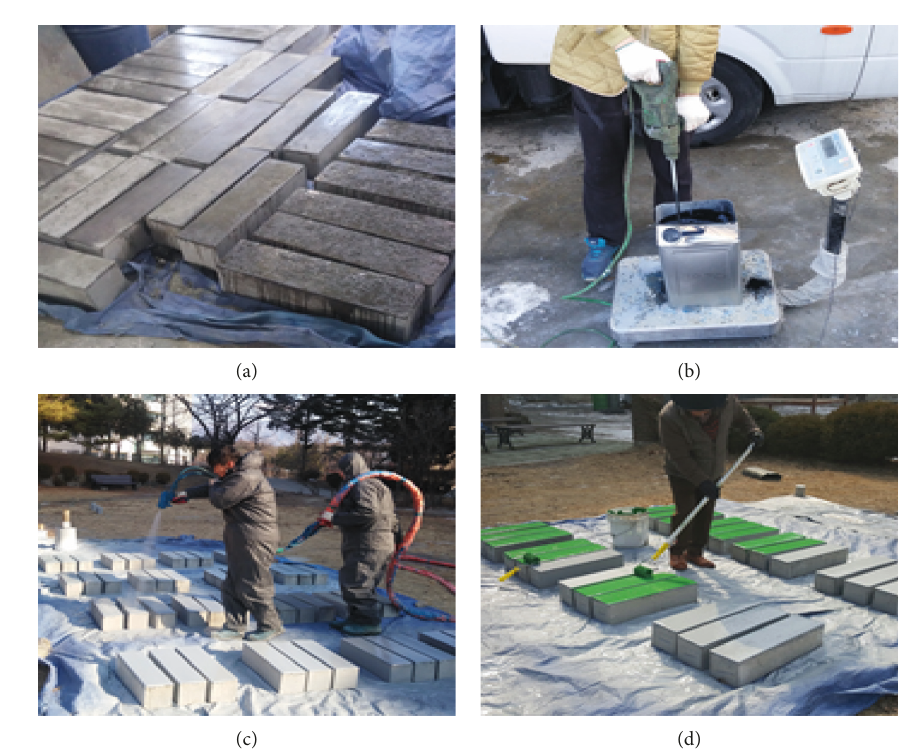
Figure 1: GFRPU coating operation of (a) primer painting; (b) mixing of prepolymer and fibers; (c) GFRPU spraying; (d) primer